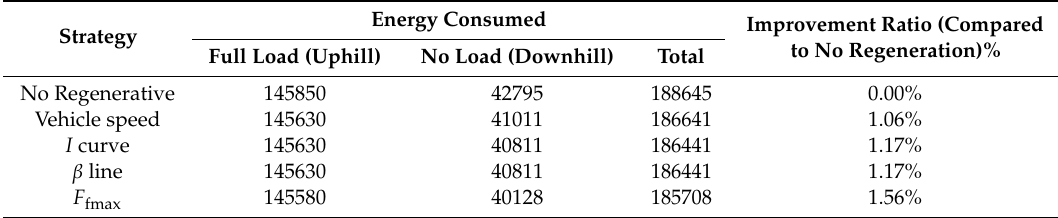
Table 5. Energy consumption of vehicle road drive cycle (f = 0.04) [kJ].